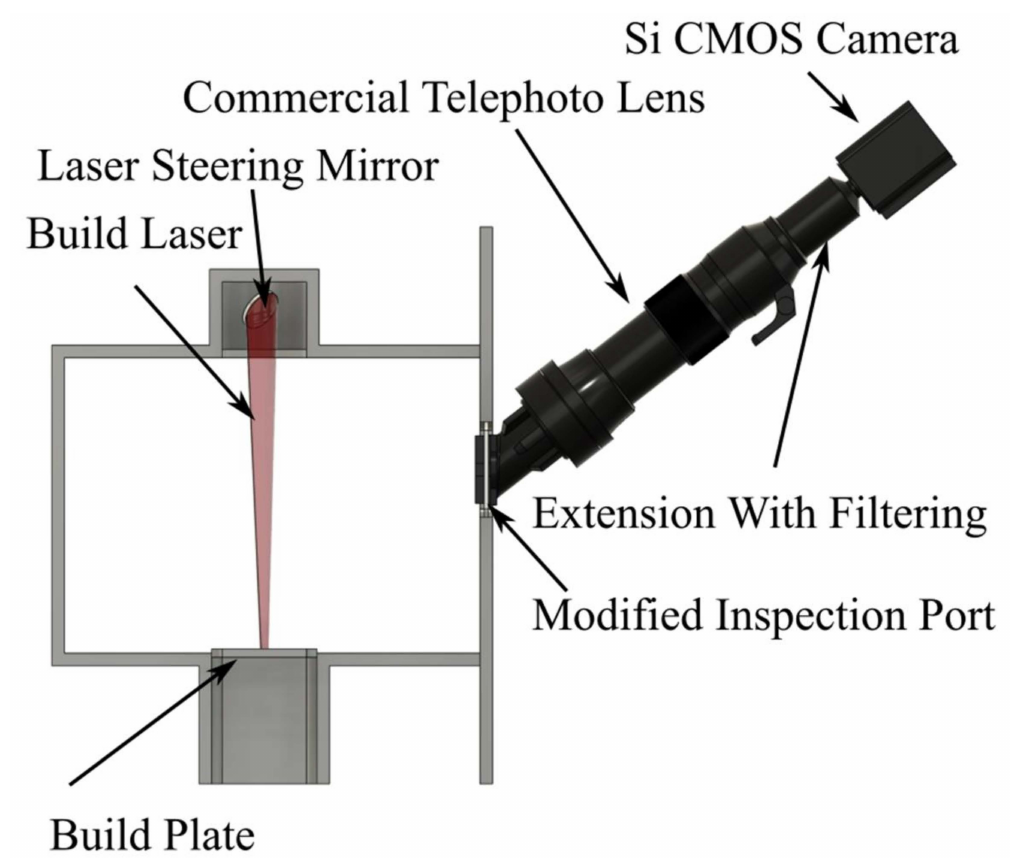
Figure 2. Schematic of modifications made to the Renishaw SLM 125 laser-based powder bed fusion machine to allow acquisition of infrared radiation emitted from the surface during the print process. Examples of calibrated output images from this measurement system can be seen in Figure